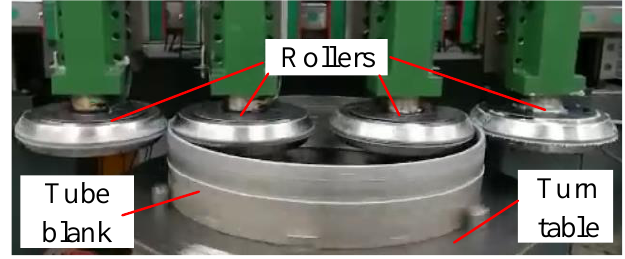
Figure 4. The experiment of the CRFF process.